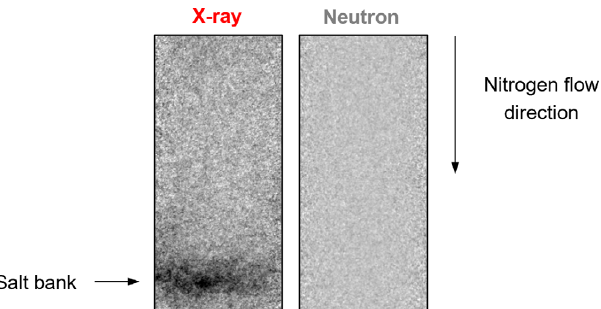
Fig. 6. 2D projections at the end of the dry-out (no capillary contact), when initially saturated with the KBr brine. On the X-ray projection, darker shades suggest a salt bank position The Neutron projection shows a fl at pro fi le con fi rming that the sample is